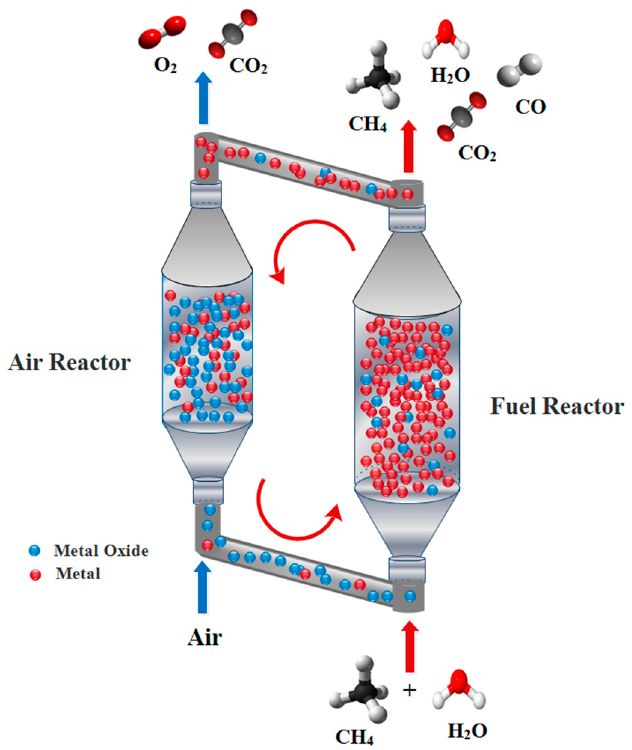
Figure 1. The schematic of CL ‐ SMR reactor for synthesis gas production.